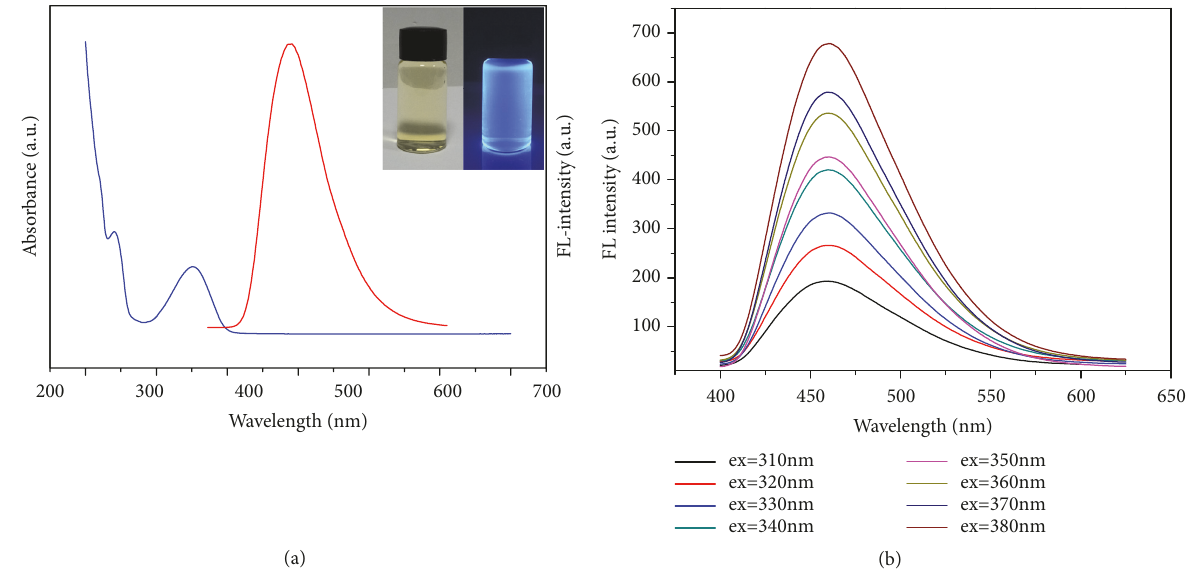
Figure 6: (a) UV-Vis absorbance and florescencespectra of N-GQDs in aqueous solution (CA:EDA=1:3); (b) photoluminescenceof N-GQDs at different excitation wavelengths.